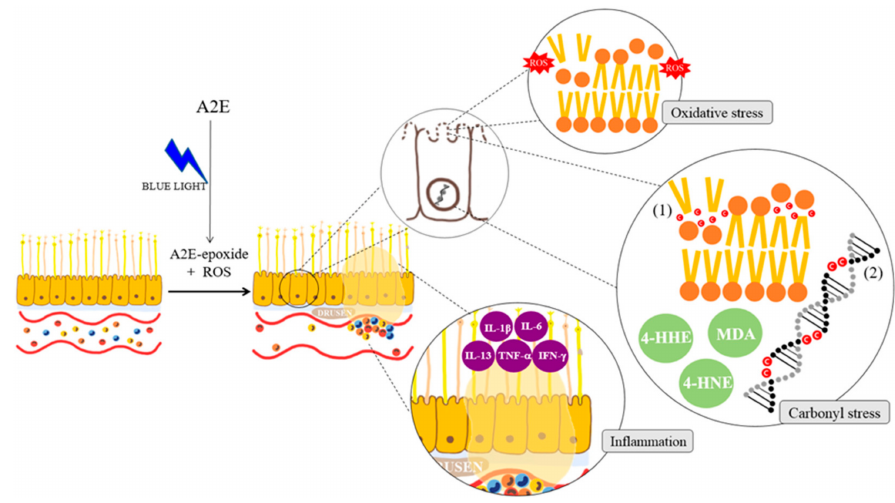
Figure 1. Age-related macular degeneration (AMD) occurrence caused by oxidative stress, carbonyl stress, and inflammation. A2E-epoxide and reactive oxygen species (ROS) are synthesized by A2E and the blue light reaction. The synthesized ROS attack the cell membrane of the retinal pigment epithelium (RPE) and destroy it via oxidative stress. The gathered ROS recruit the immune cells and secrete immune mediators, such as IL-1 β , IL-6, IL-13, TNF- α , and IFN- γ (inflammation). The attack of ROS on the cell membrane in RPE initiates the carbonylation of (1) the cell membrane’s lipid layer and (2) DNA, and carbonylated products, such as malondialdehyde (MDA), 4-hydroxynonenal (4-HNE), and 4-hydroxyhexanal (4-HHE), disrupting the cell membrane and DNA (carbonyl stress). The correlation of these stresses induces RPE cell death (apoptosis). ©: